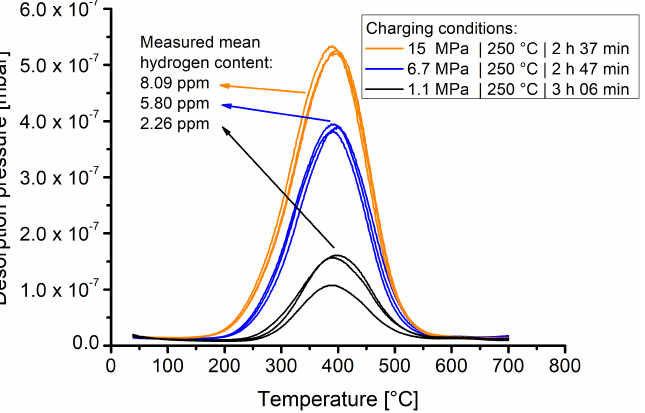
Figure 5. TDS spectra collected from samples that were exposed to gaseous hydrogen at 250 ◦ C at pressures of 1.1, 6.7 and 15MPa for given